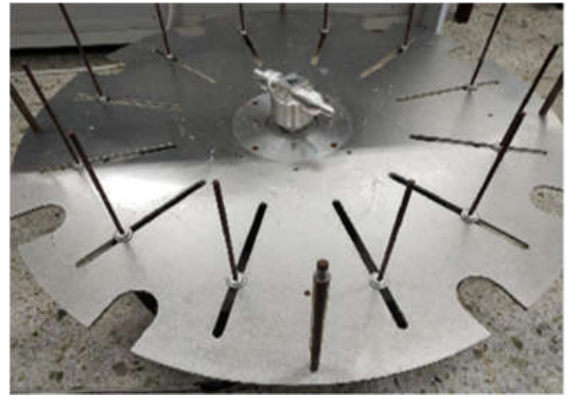
Figure 7. High-speed centrifugal spinning equipment used in the experiments.